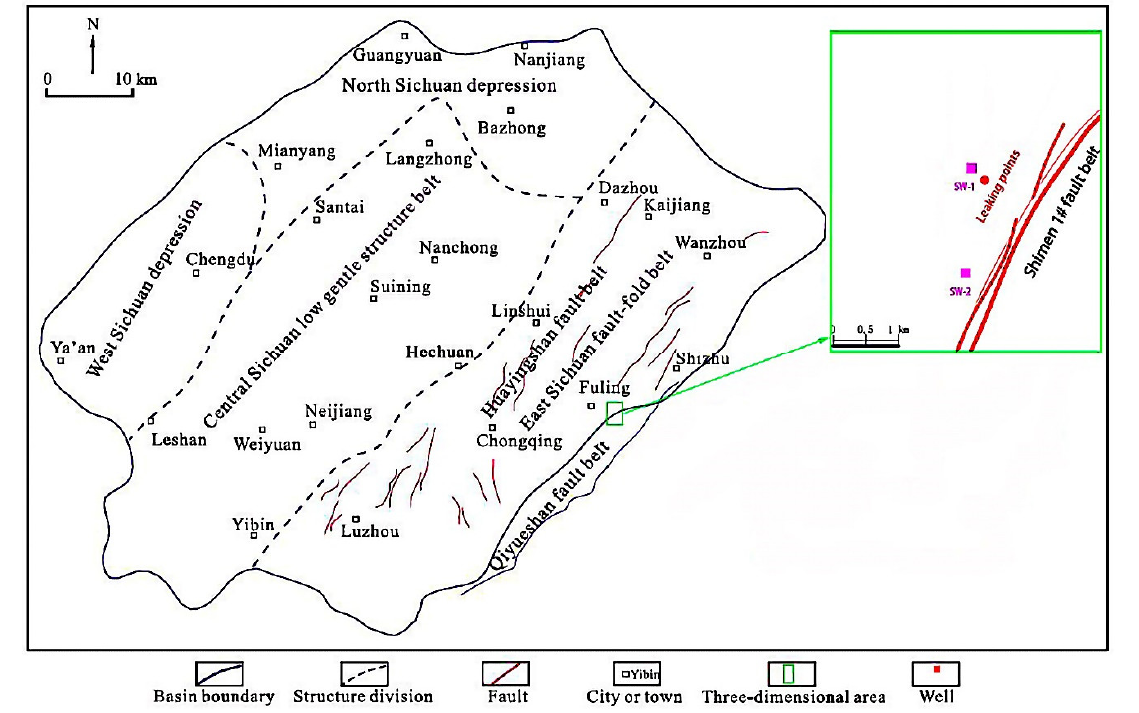
Figure 1. Locations of the shale gas wells and the leaking points in Fuling area (modified from Qin et al. [21]).